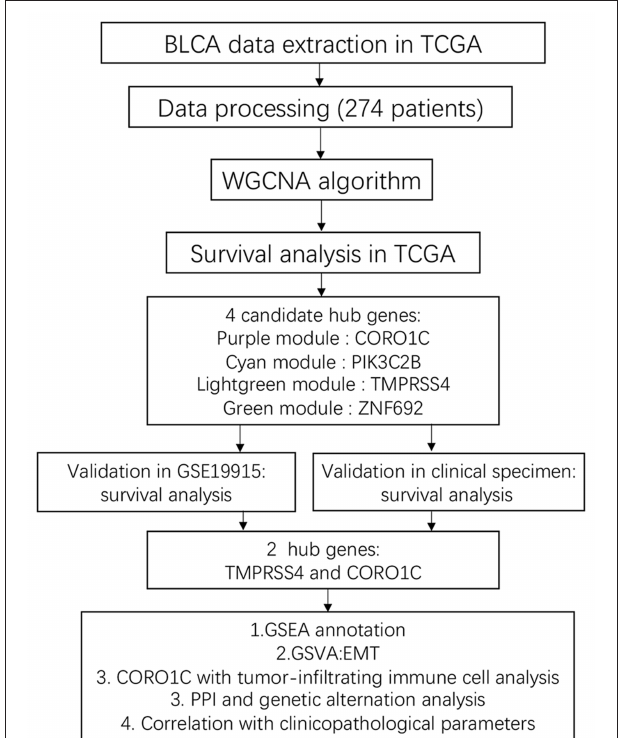
FIGURE 1 | Flowchart design of the